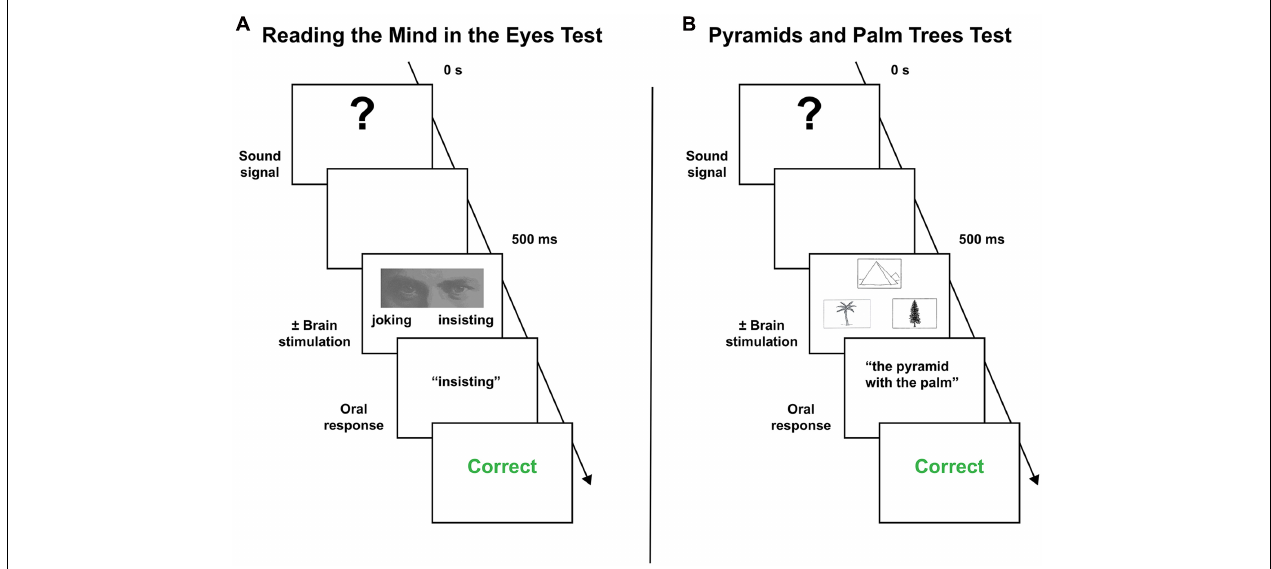
FIGURE 1 | Behavior paradigms employed during the intraoperative mapping. (A) Mentalizing task. (B) Visual semantic cognition task (see the main text to a complete description of the behavioral